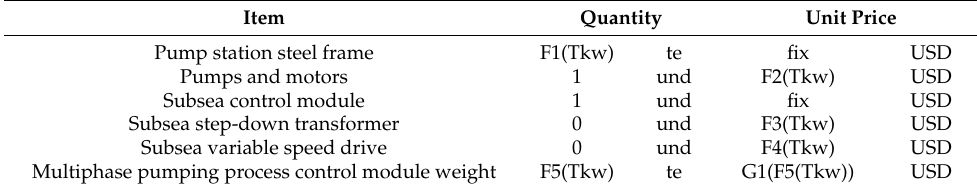
Table 5. Cost structure of a subsea multiphase pump.